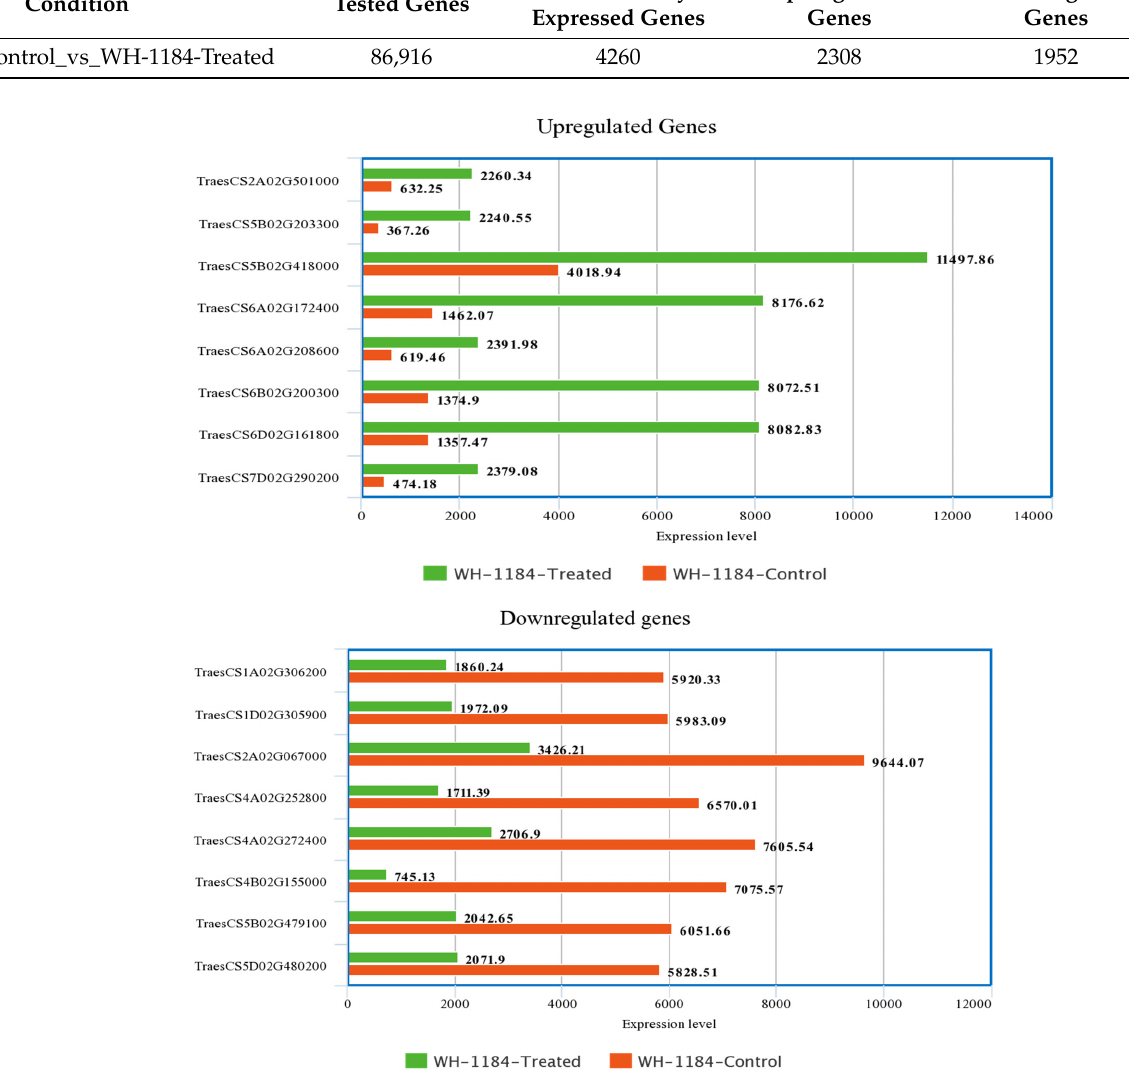
Figure 1. Comparison of highly expressed eight genes under both the conditions. Out of total upregulated and downregulated genes, the expression level of only highly expressed eight genes was taken into consideration for comparison. Upregulated genes which showed thehighest expression level encoded ATP-synt_C do- main-containing protein(TraesCS6A02G208600) and putative proteins whereas down- regulated genes with greatest expression level that encoded putative proteins, ribulose bisphosphate carboxylase small subunit (RuBisCO small subunit) and Pept_C1 do- main-containing protein (TraesCS4A02G252800), were compared to show their expres- sion level in two different conditions. Heat stressed plants exhibited higher expression level of upregulated genes while plants grown under controlled conditions had higher expression level of downregulated gene as compared to heat stressed plants. A descrip- tion of expression level of regulated genes is presented in Supplementary Materials. The expression profile of differentially expressed genes or to show the how much the genes upregulated and downregulated across the samples is indicated in volcano plots that were constructed as x-axis log 2 fold change versus y-axis –log10 ( p value) (Figure 2). Blue dots represent log 2 FC ≥ 1 and p -value ≤ 0.05. Pink dotted lines represent absolute log 2 FC ≥ 1and FDR/adjusted p -value ≤ 0.05. This is also used to visualize the bi- ological relevance as well as statistical significance of the genes. So, the values on x-axis represent the biological relevance while y-axis shows statistical significance. The FC value ≥ 1 indicate upregualtion of genes while it is less than 1 shows downregulated genes. One horizontal line represents statistical significance values while two vertical lines represent upregulation and downregulation of genes. The genes between these two vertical lines were discarded for further analysis. This plot indicated that the upregulated genes are greaterin number than the downregulated ones.